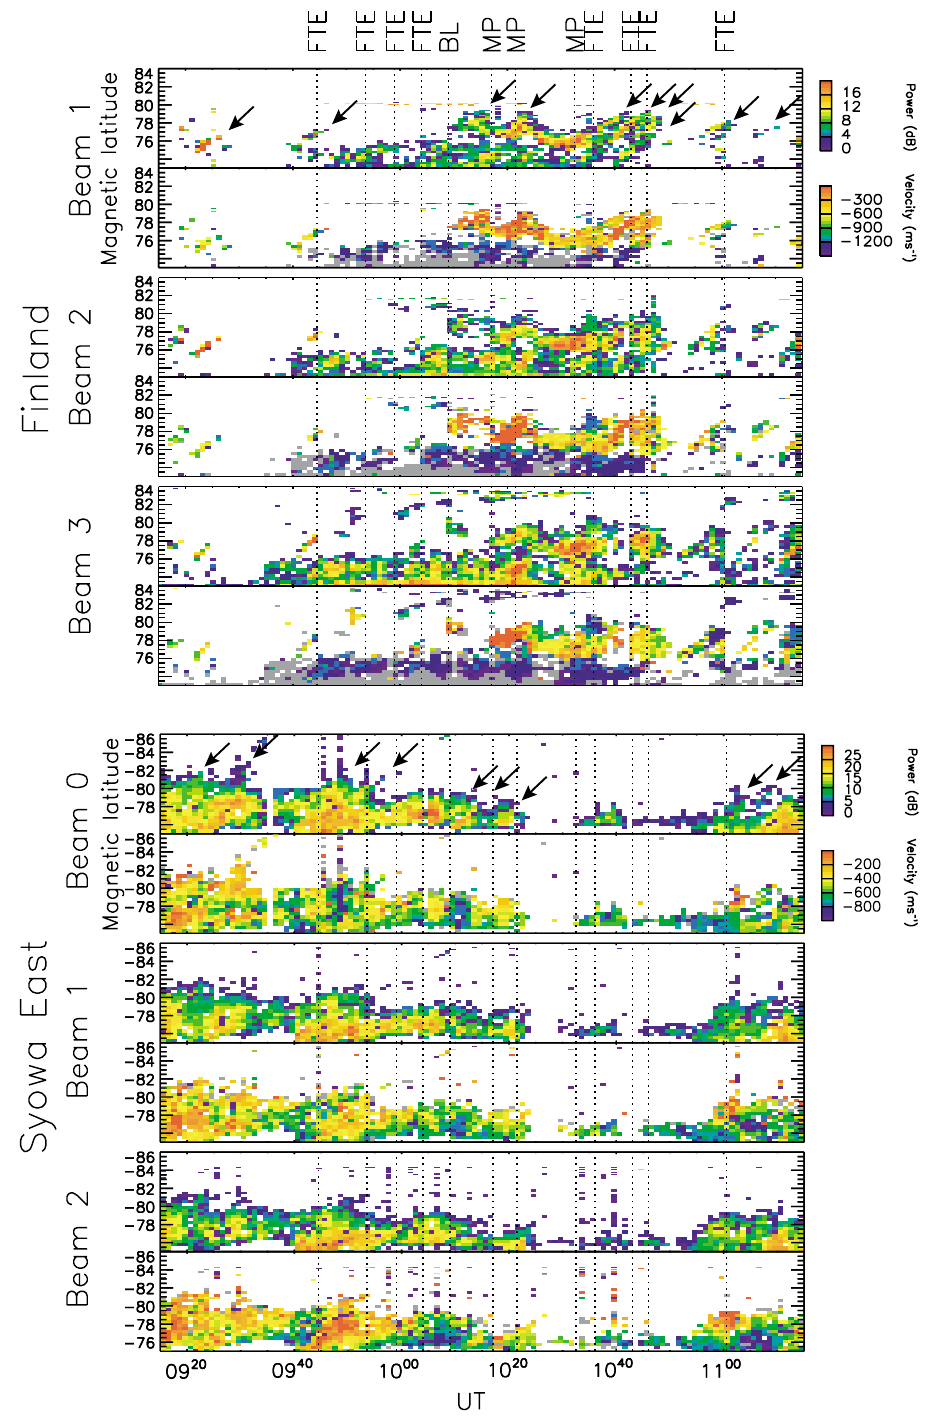
Figure 5 Fig. 5. Three pairs of backscatter power and Doppler shift measurements from (a) beams 1, 2, and 3 of the Finland radar and (b) beams 0, 1, and 2 of the Syowa East radar, covering the same time interval as for the Cluster data in Fig. 3. In the Doppler shift panels, velocities are only shown where significant power is observed. Grey backscatter indicates ground backscatter, and negative velocities represent Doppler shifts away from the radar along the line-of-sight. Poleward-moving radar auroral forms (PMRAFs) are indicated by arrows in the upper power panel for each radar; related events are observed in each of the other beams shown. Superimposed on each panel are the times of note identified in the Cluster observations, as in Fig.